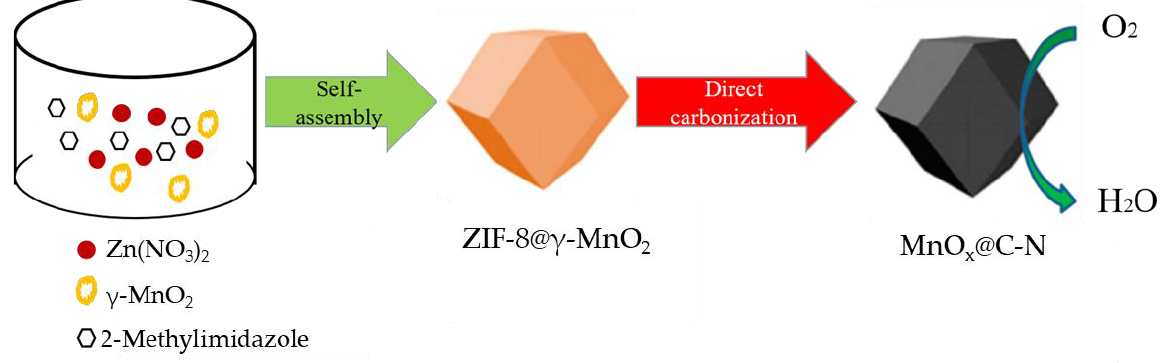
Figure 1. A schematic diagram showing the synthesis of MnO x @C-N.